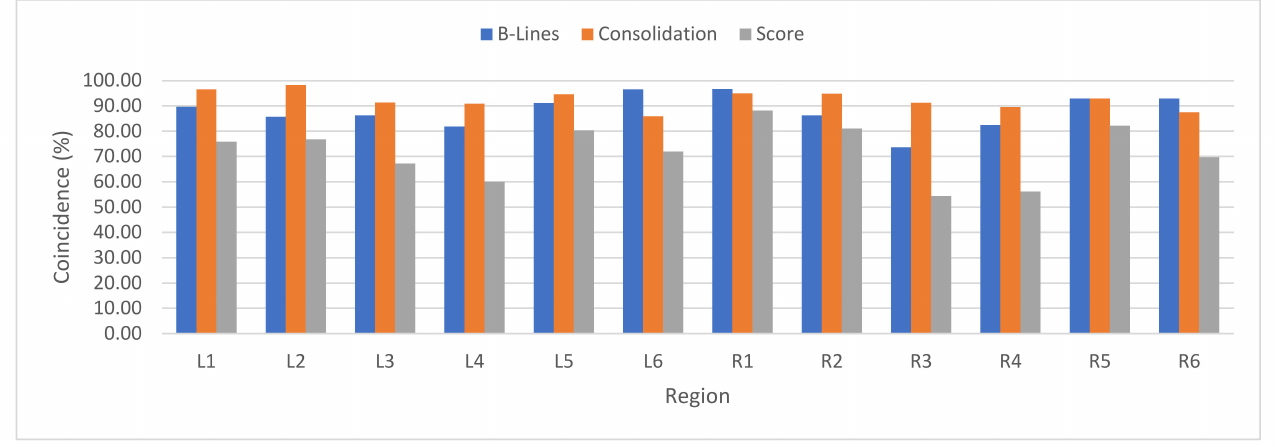
Figure 6. Automatic detection coincidence by zone for B-Lines (blue), consolidations (orange), and zone score